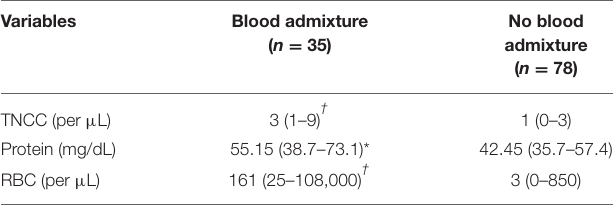
TABLE 6 | Comparison of fluid analysis parameters in blood admixed vs. non-blood admixed samples using subjective pathologic